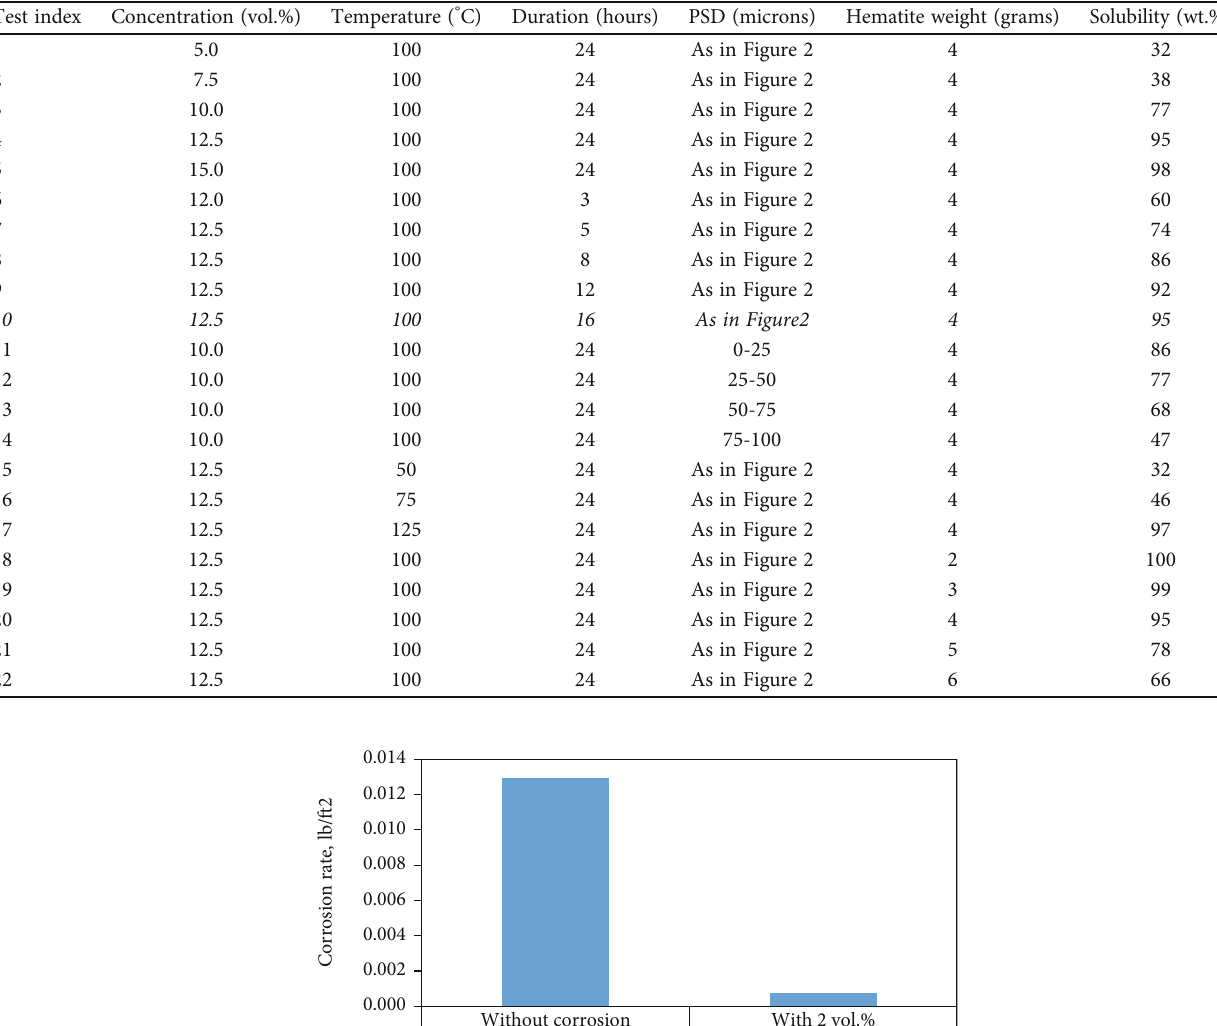
Figure 8: Solubility of 4 grams of hematite over 24 hours. Table 3: Summary of the solubility tests.